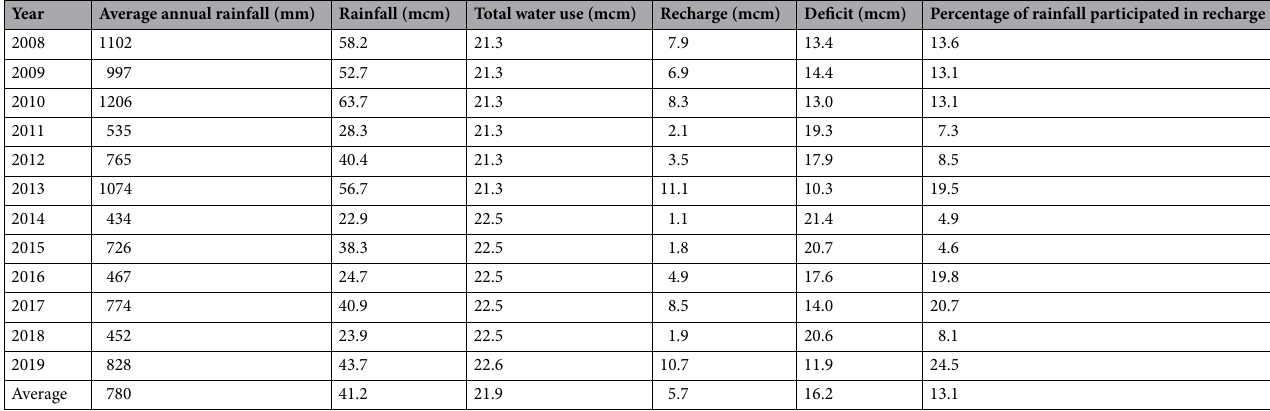
Table 3. Groundwater recharge and use in the study area. mcm million cubic meters.